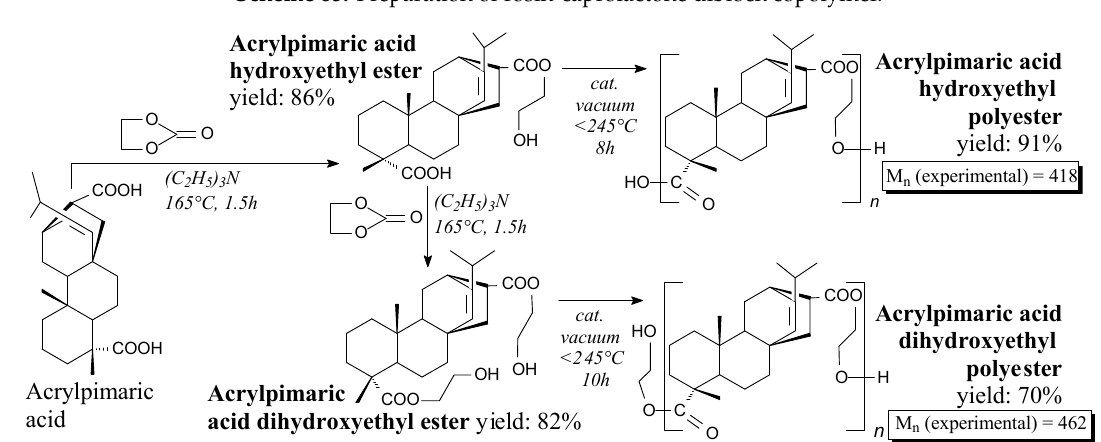
Scheme 86. Preparation of acrylpimaric acid hydroxyethyl polyester.